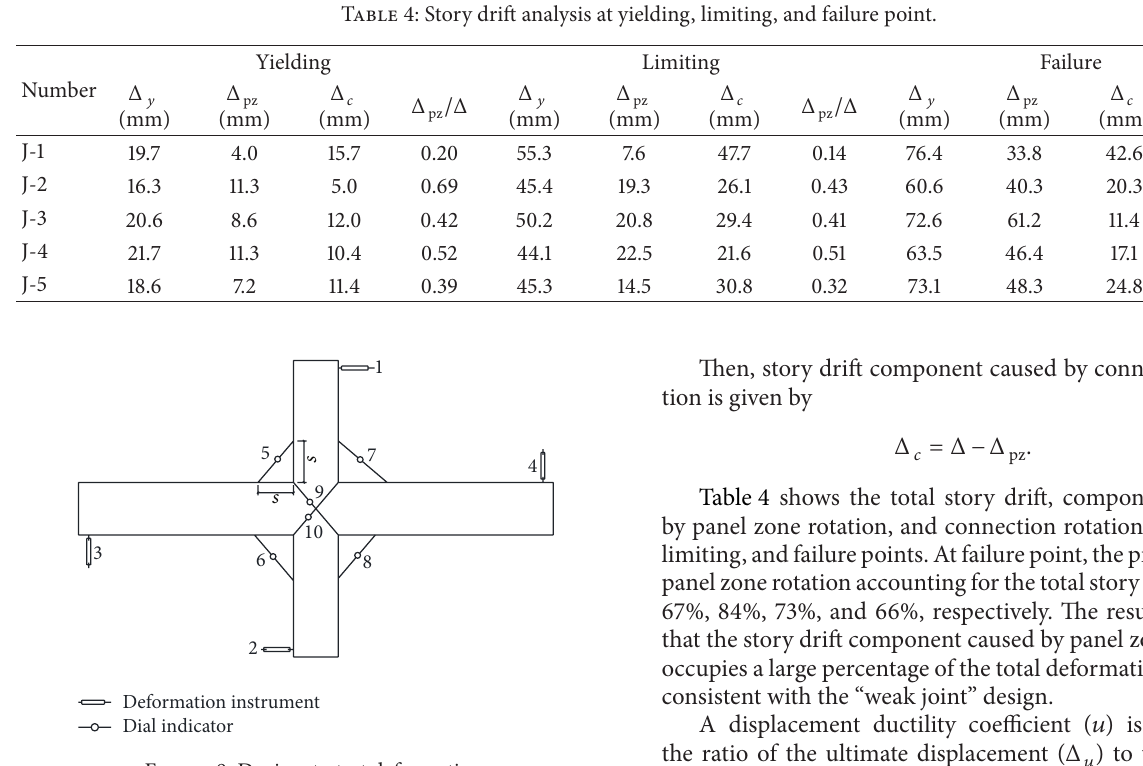
Figure 9: Devices to test